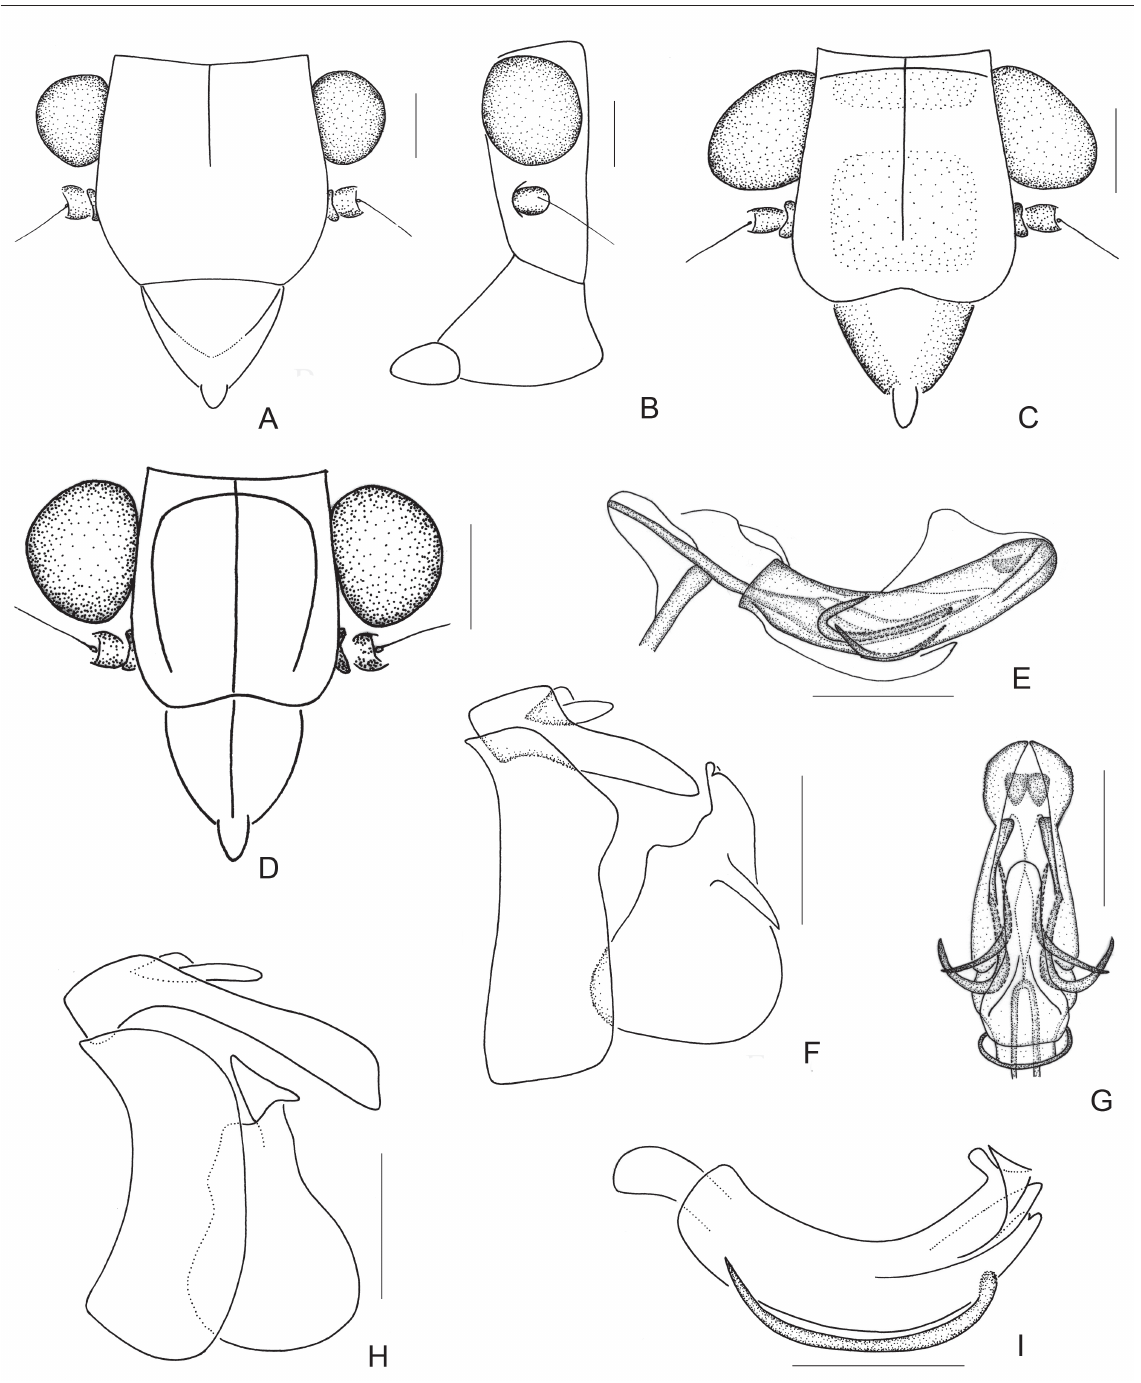
Fig. 3. — A . Eusudasina nantouense Yang, 1994, frons and clypeus. B . Same, lateral view. — C . Gelastyrella litaoensis Yang, 1994, frons and clypeus. — D . Eusarima sp., frons and clypeus. — E . Dentatissus damnosus (Chou & Lu, 1985), penis, left view. F . Same, male genitalia, lateral view. G . Same, penis, ventral view. — H . Kodaianella bicinctifrons Fennah, 1956, male genitalia, lateral view. I . As previous, penis, left view. Scale bars = 0.5